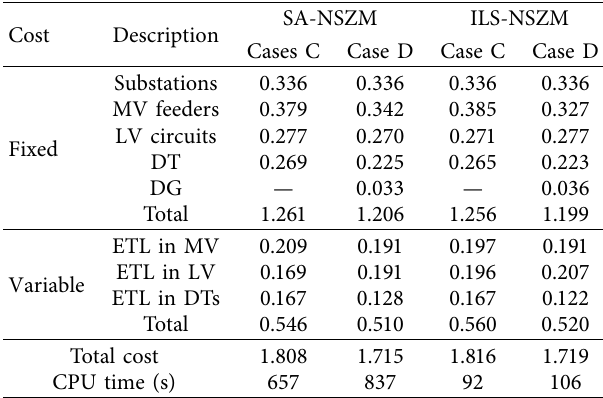
Table 4: Comparison of best solutions in millions of USD—cases